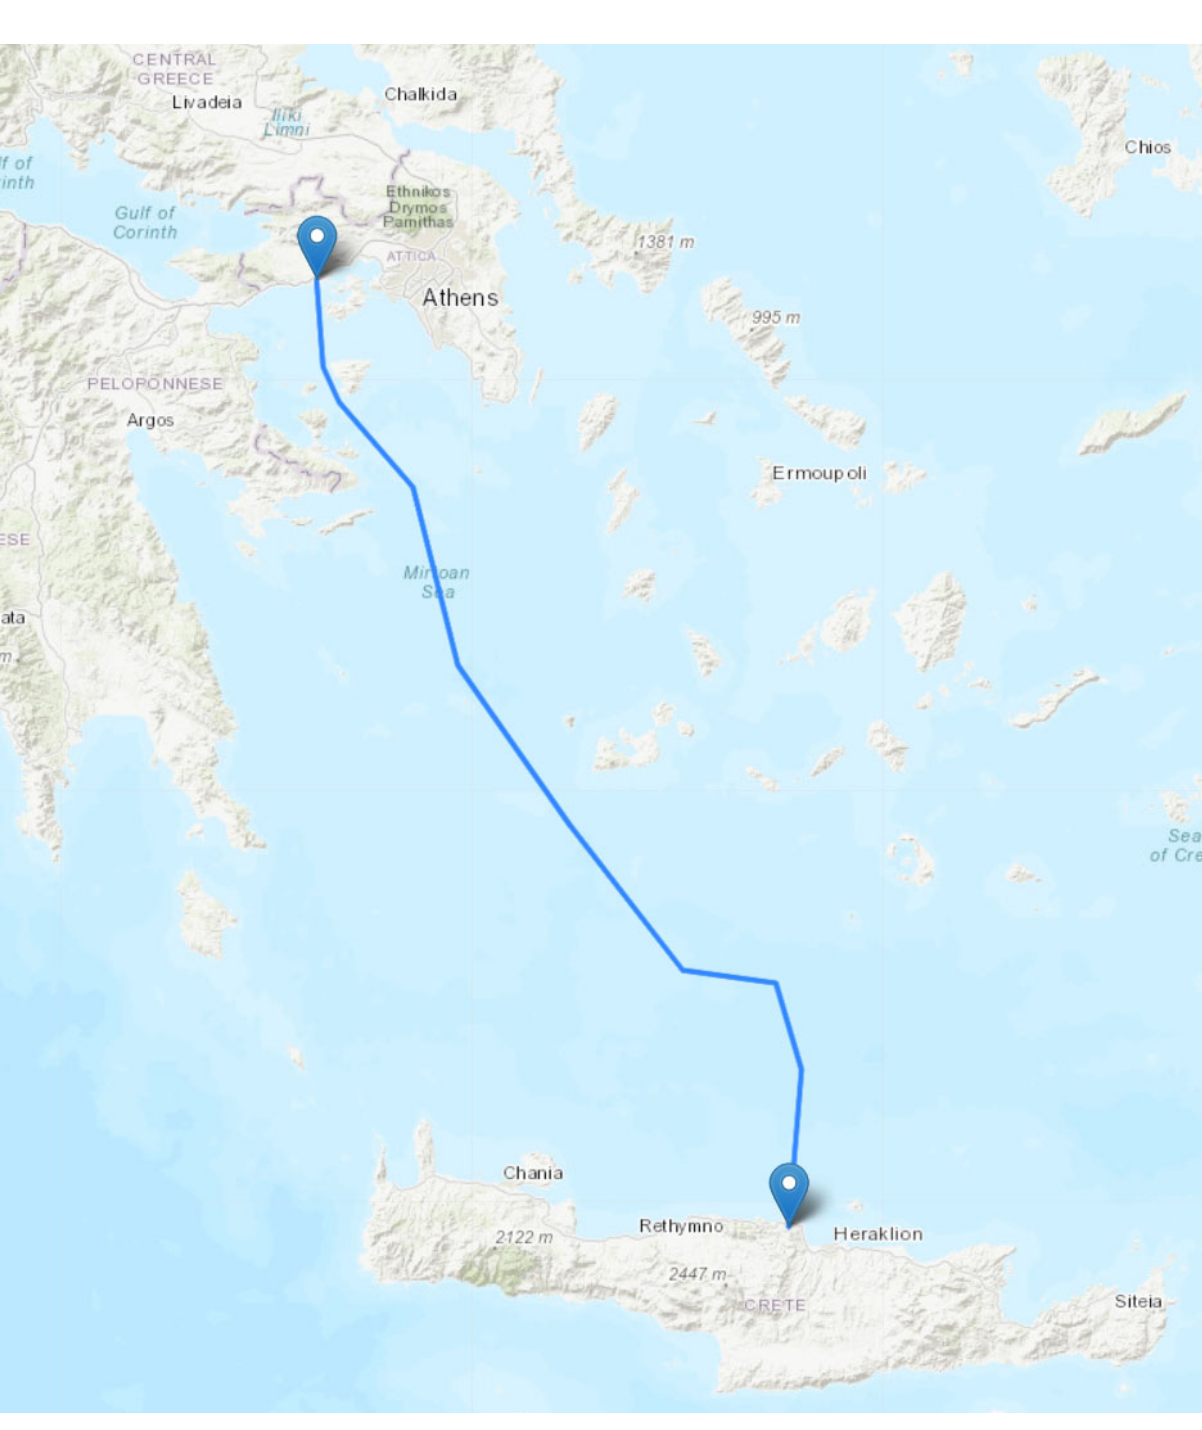
Figure 1. Geographical map of the interconnection between Crete (electrode station in Korakia beach, converter station in Damasta) and continental Greece power systems in Attica (electrode station in Stachtoroi island, converter station in Koumoundourou) [51].